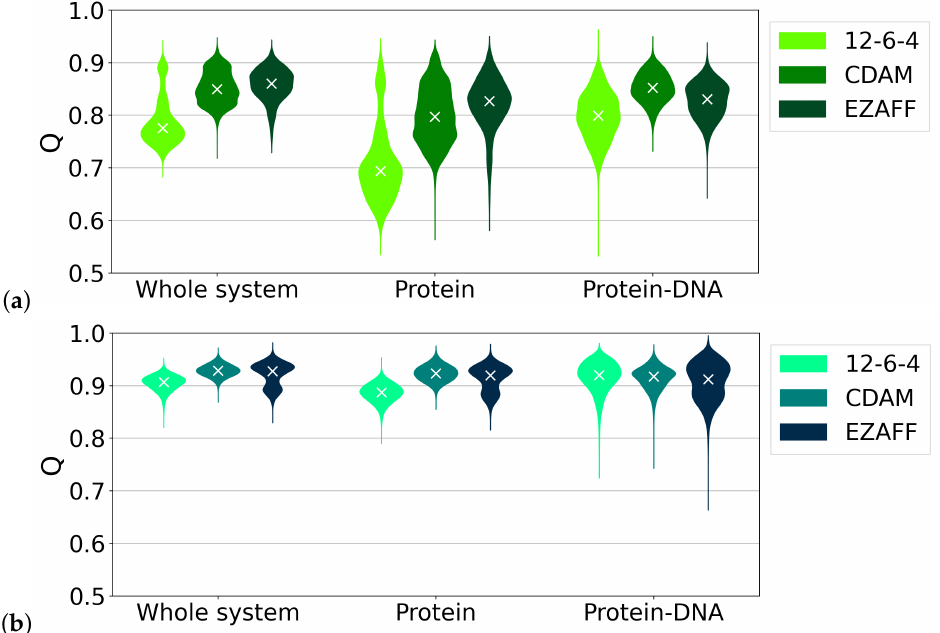
Figure 5. Fraction of native contacts, Q , of ( a ) MLL1 and ( b ) WT1. White crosses mark the median fraction of native contacts. Table 1. Observed coordination geometries in MLL1 and WT1